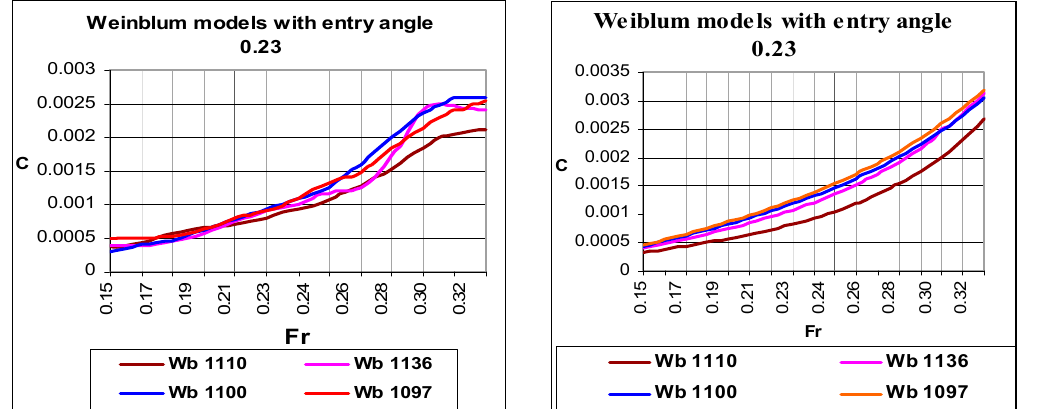
Figure 13. Weinblum’s models with the same dimensions and entry angle of the main waterline. ( a ) Residual resistance; ( b ) main part of Michell integral of these models.